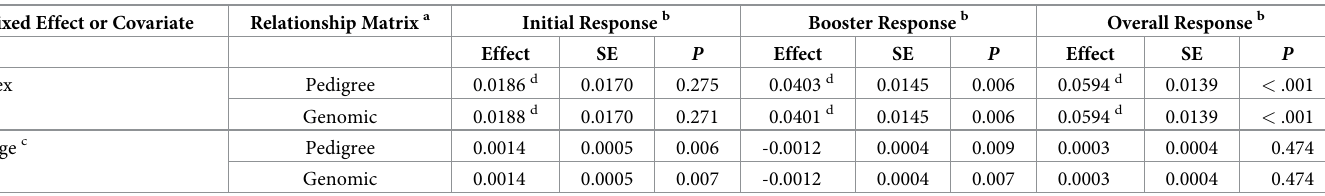
Table 3. Fixed effects and covariates (± SE) for humoral response to E . coli O157:H7 Siderophore and Receptor Porin (SRP) protein vaccination in calves ( n =